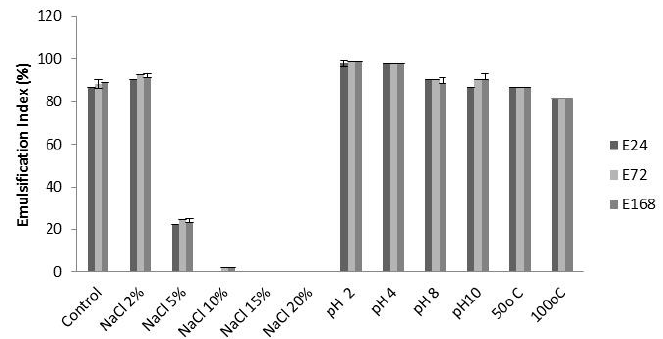
Figure 3. Emulsification index of bioemulsifier produced by Candida lipolytica UCP 0988 against burnt engine oil when NaCl concentrations, pH and temperature were varied.